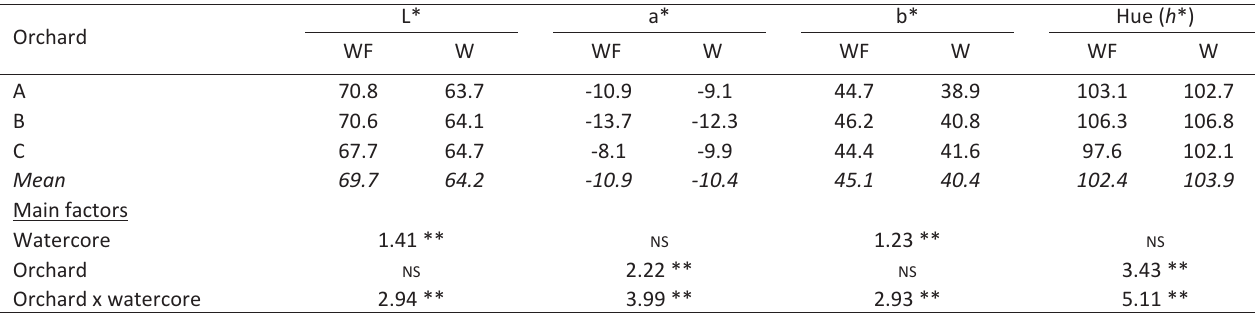
Table 3 ­ Color parameters of watercore­free (WF) and watercore (W) fruit of ‘Pomella Genovese’ (**=P<0.01).Orchard LSD values for the two main factors and their interaction are reported at the bottom